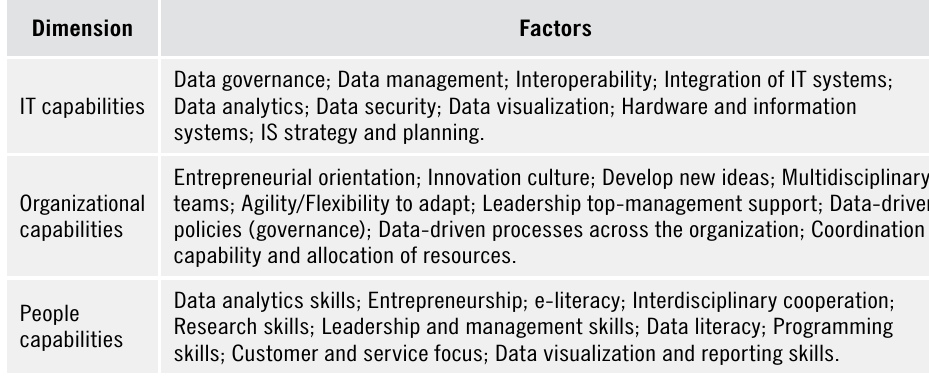
Table 1. Open data innovation capabilities framework (adapted from Eckartz et al., 2016) Dimension